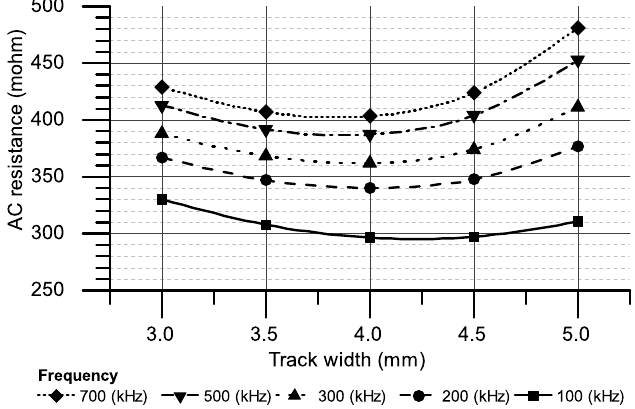
Figure 11. AC resistances of ten-turn PCB windings.